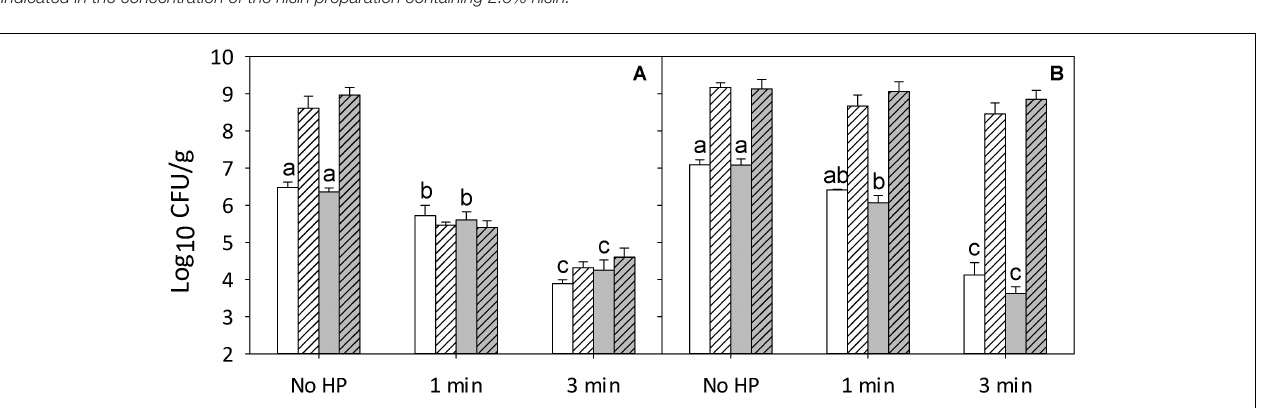
FIGURE 1 | Effect of pressure on survival and post-pressure growth of L. monocytogenes and RTE meat microbiota on ham treated with rosemary extract or an equivalent volume of 0.5% ethanol as solvent control. Shown are cell counts of ham inoculated with a 5-strain cocktail of L. monocytogenes (A) or RTE meat microbiota (B) after treatment at 500 MPa for 1 or 3 min without (white) or with (gray) rosemary extract at ∼ 325 µ g/cm 2 . Cell counts of L. monocytogenes and other strains were monitored immediately after pressure treatment (solid columns) and after storage for 4 weeks at 4 ◦ C (hatched columns). Surviving cells were enumerated by surface plating on non-selective TS ( L. monocytogenes ) or APT agar (RTE meat microbiota). Data are shown as means ± standard deviations of triplicate independent experiments. Treatment means (solid columns) within each panel with different letters are significantly different ( P < 0.05). The interception point of abscissa and ordinate represents the highest detection